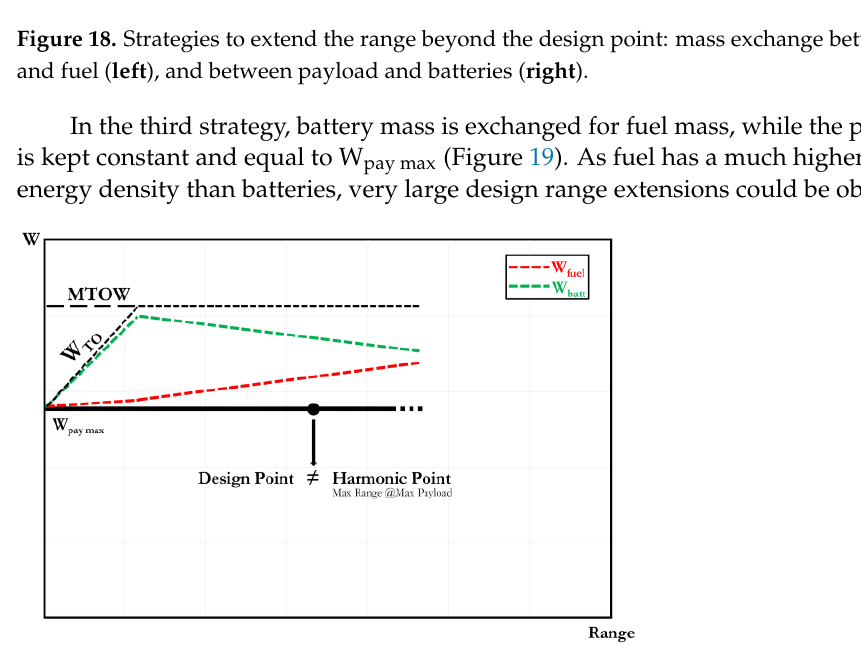
Figure 19. Strategy to extend the range beyond the design point: batteries and fuel mass swap.